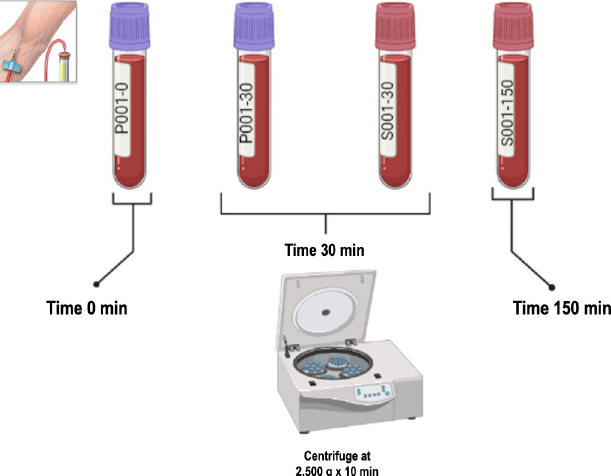
Fig 1. Schematic of both the labeling procedure and the centrifugation of each tube in which the peripheral blood sample will be obtained. Each participant will have 12 ml of peripheral blood (04 tubes) drawn using 02 tubes with EDTA K3 as anticoagulant and 02 tubes without additives (to obtain serum). The peripheral blood samples obtained will be centrifuged for 10 min at 2500 g and then either plasma or serum will be aliquoted and stored at -80˚C until processing. In the case of samples with EDTA K3 as the anticoagulant, one tube shall be centrifuged as soon as the blood sample is withdrawn and the other tube after 30 min at room temperature. For samples without anticoagulant, one tube shall be centrifuged after 10 min at room temperature and the other after 30